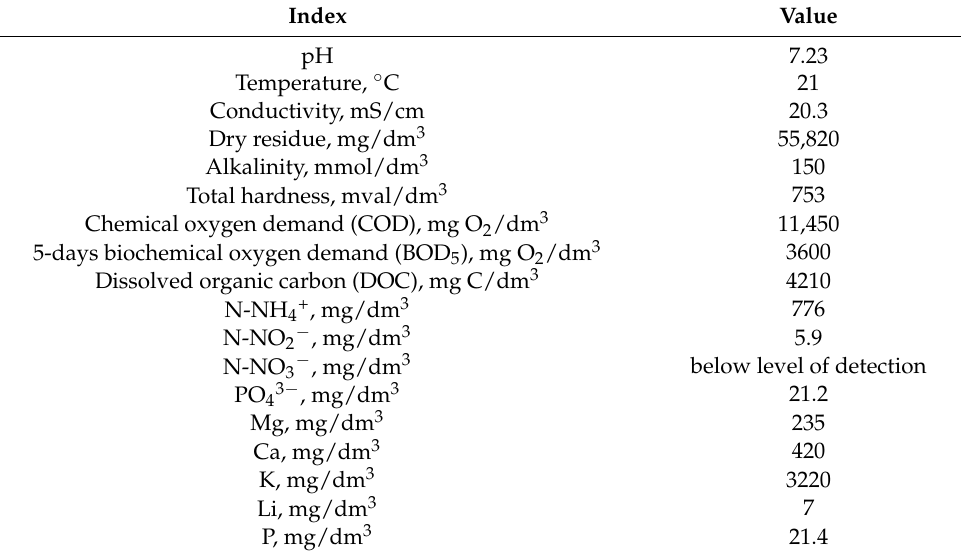
Table 1. Properties of the liquid fraction of municipal digestate.